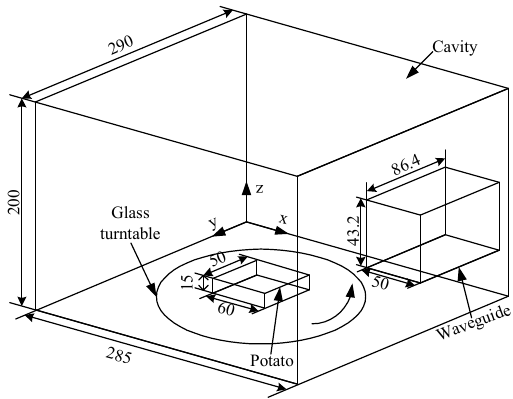
Figure 2. Schematic of the microwave oven system used for modeling (all sizes in millimeters). Table 1. Input parameters used in the simulations.